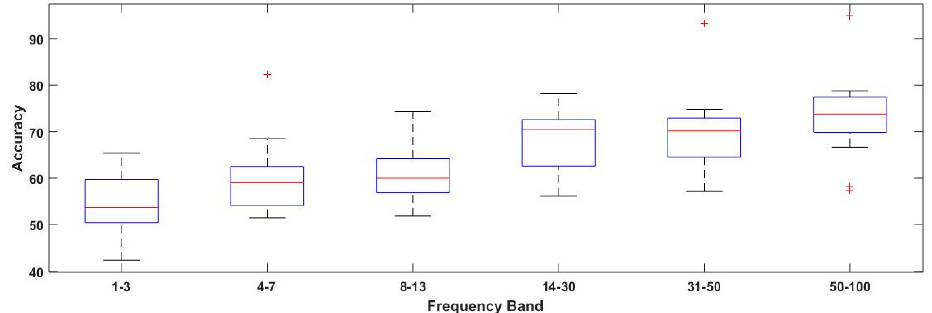
Figure 4. Box plot for classification accuracies with respect to frequency bands as obtained from Table 3. + symbol shows the outliers, while red line represents the median values.